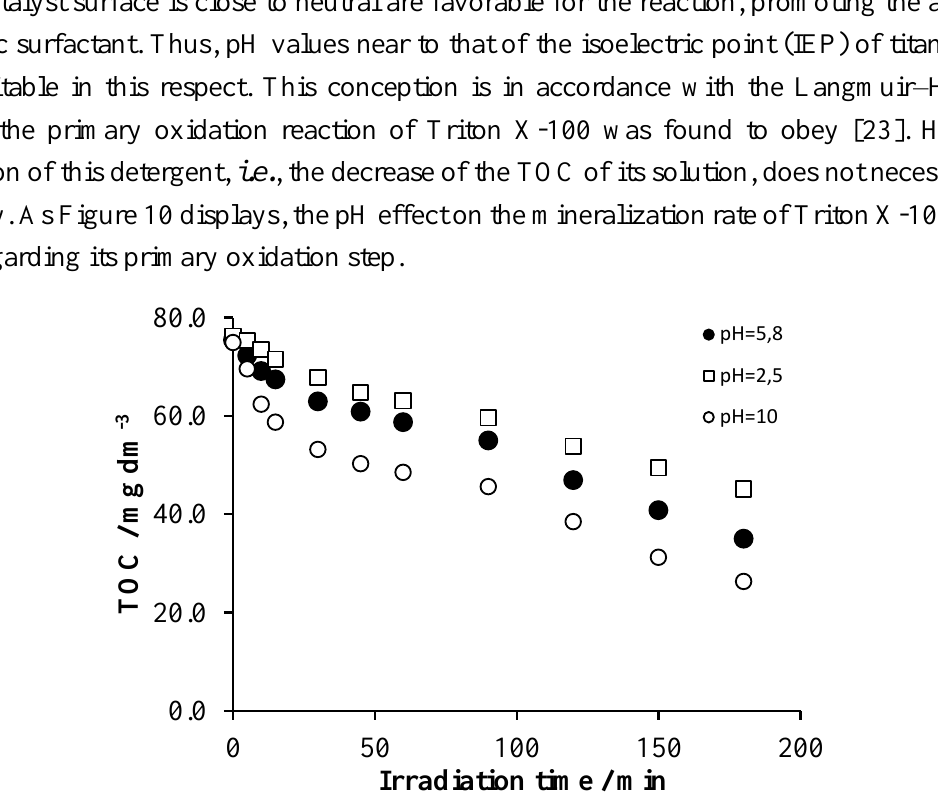
Figure 10. The change of the TOC as a function of the irradiation time at various pH values in the aerated system containing 2 × 10 −4 mol·dm −3 Triton X-100 and 1 g·dm −3 TiO 2